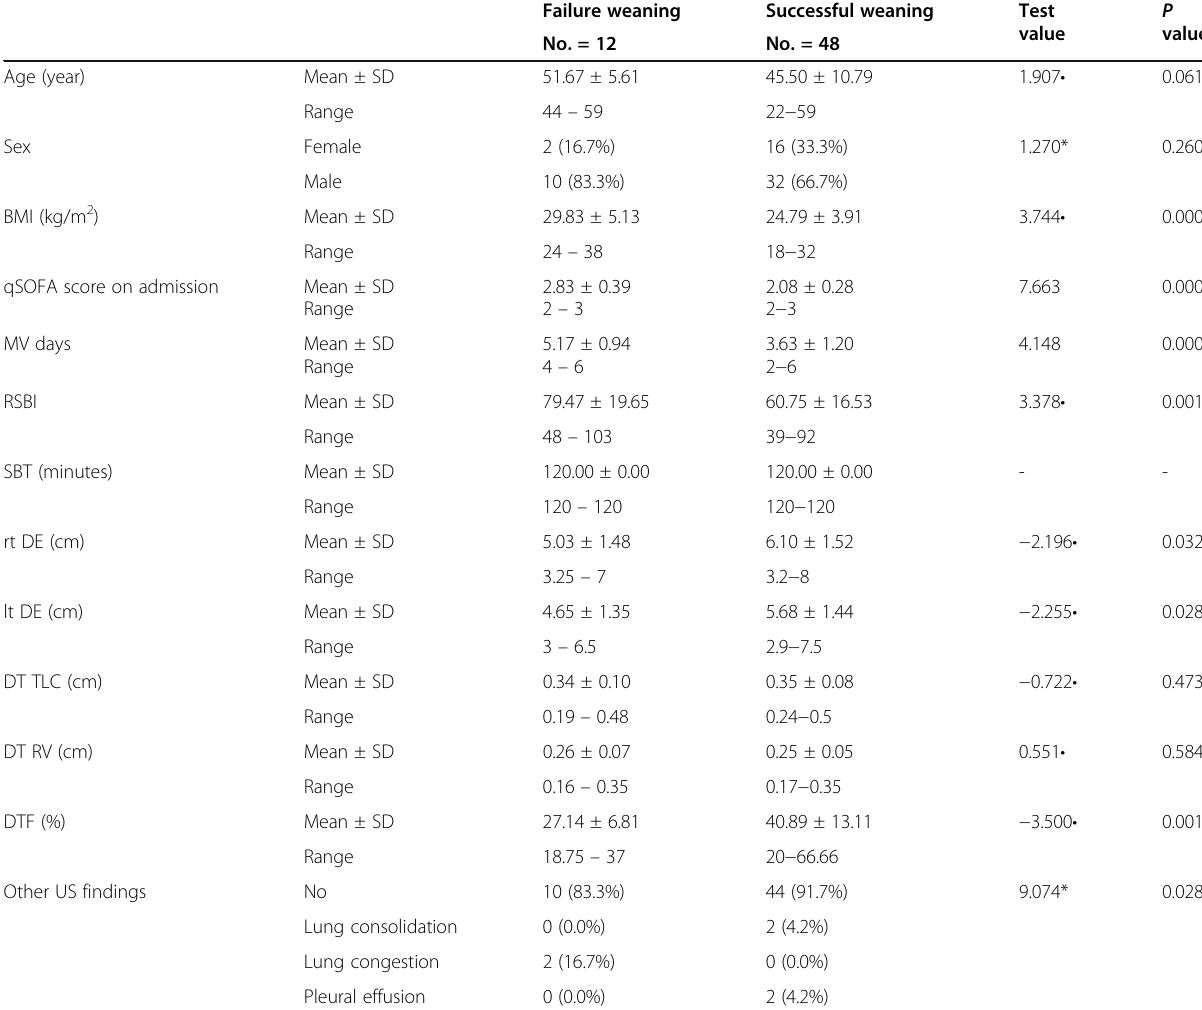
Table 1 Demographic data and patient characteristics